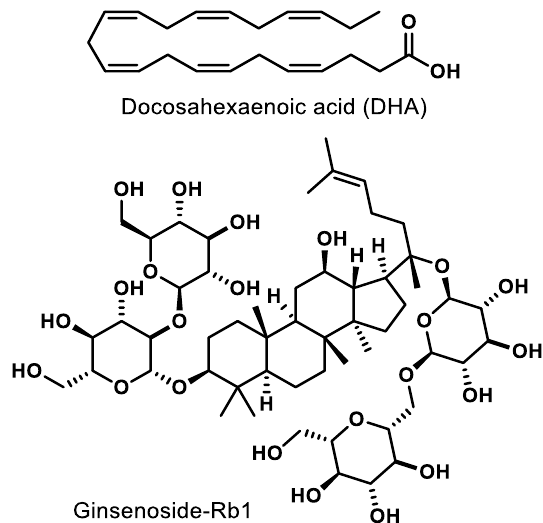
Figure 3. Representative natural product PPARγ ligands.